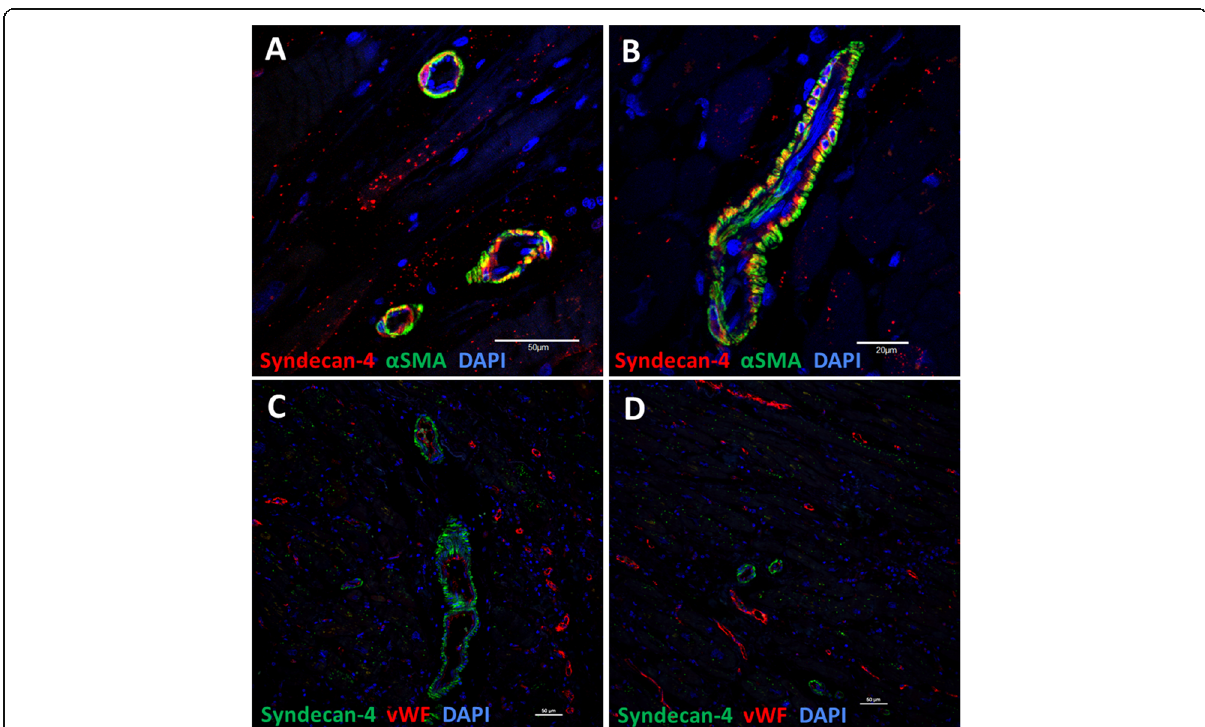
Fig. 5 Expression of syndecan-4 in heart sections of subjects with CCC. Sections of explanted human hearts from subjects with CCC were stained with anti-syndecan-4 antibody and α -smooth muscle actin - α -SMA ( a and b ) or von Willebrand factor - vWF ( c and d ). Sections were co-stained with DAPI and observed by confocal microscopy